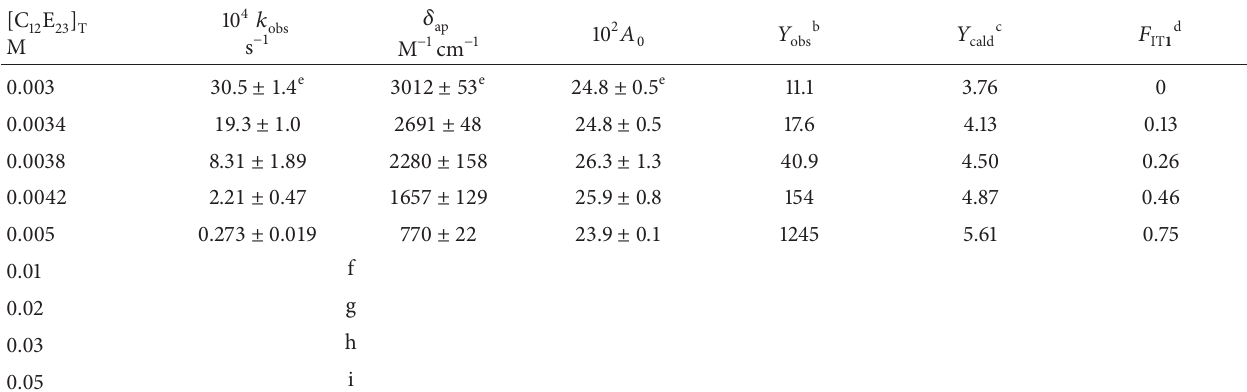
, 𝛿 , and 𝐴 0 for alkaline hydrolysis of 1 in the presence of C 12 E 23 a . obs ap